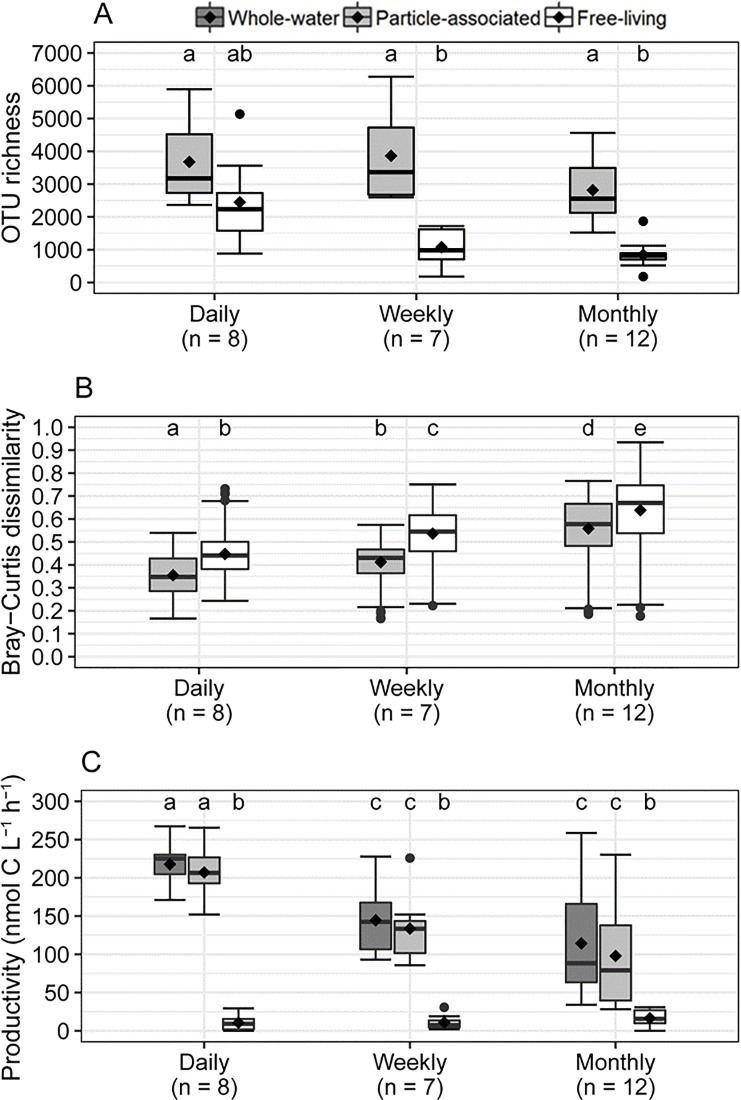
Boxplots showing variance in bacterial assemblage (A) OTU richness (B) Bray–Curtis dissimilarity, and (C) production (3H-leucine) among sampling timescales. Boxes show medians (dark lines), averages (diamonds), and inter-quartile ranges. Whiskers indicate data within 3X inter-quartile ranges, and points are outliers. Letter(s) above boxes indicate the groups of samples that are significantly different in their medians (Mood’s median tests: p < 0.001). Sample sizes are presented for each timescale.